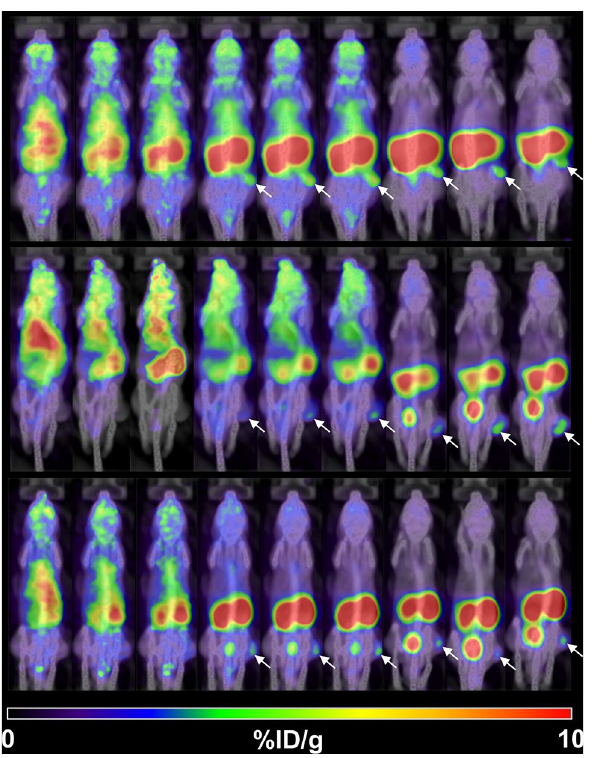
Figure 1. PET/CT images of the subcutaneous prostate cancer xenograft model mice ( n = 3, each row) at various time-points (from left to right in each column: 2, 5, 10, 30, 60, 90, 180, 240, 300 min p.i., respectively) after the intravenous injection of [ 68 Ga]PSMA-11. The arrows indicate the PSMA-positive tumor (22Rv1). %ID/g, percent injected dose per gram of